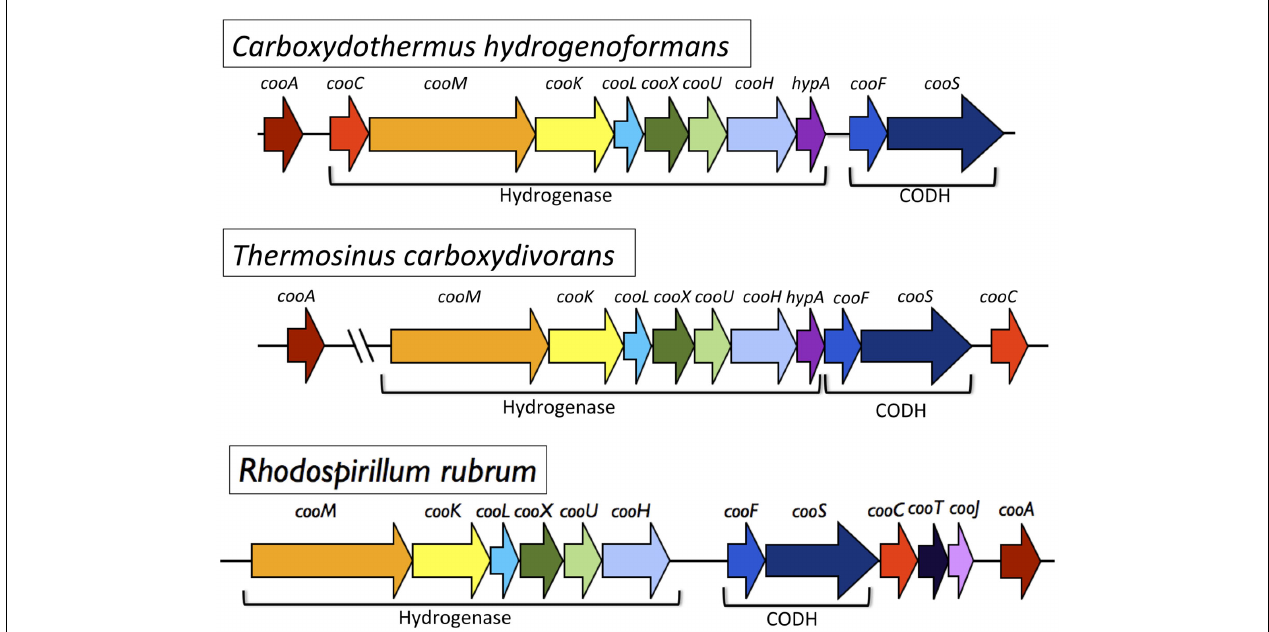
space between hypA and the cooF in C. hydrogenoformans. Additionally the T. carboxydivorans cooA gene is located 254kb away from the rest of the gene cluster.While the R. rubrum gene cluster has many of the same genes, there are notable differences in the genes encoding the hydrogenase accessory proteins (i.e . , presence of cooT and cooJ in R. rubrum instead of hypA